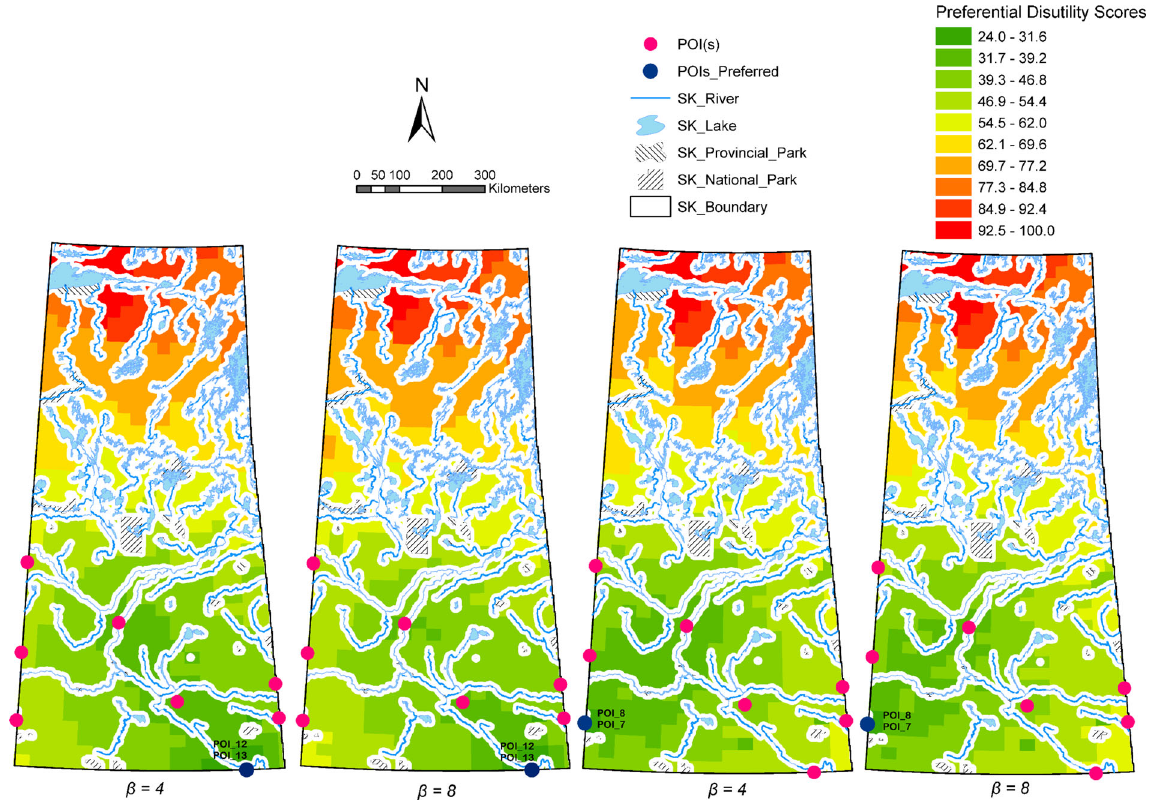
Fig. 12 Case III heat maps showing the impact of different b values on preferred POIs